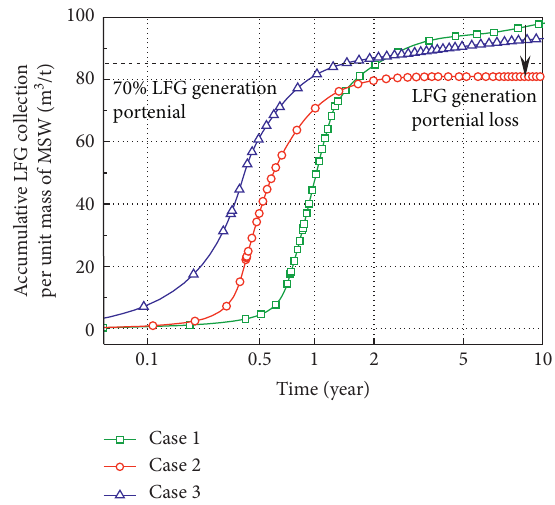
Figure 5: Landfill gas collection under different recirculation